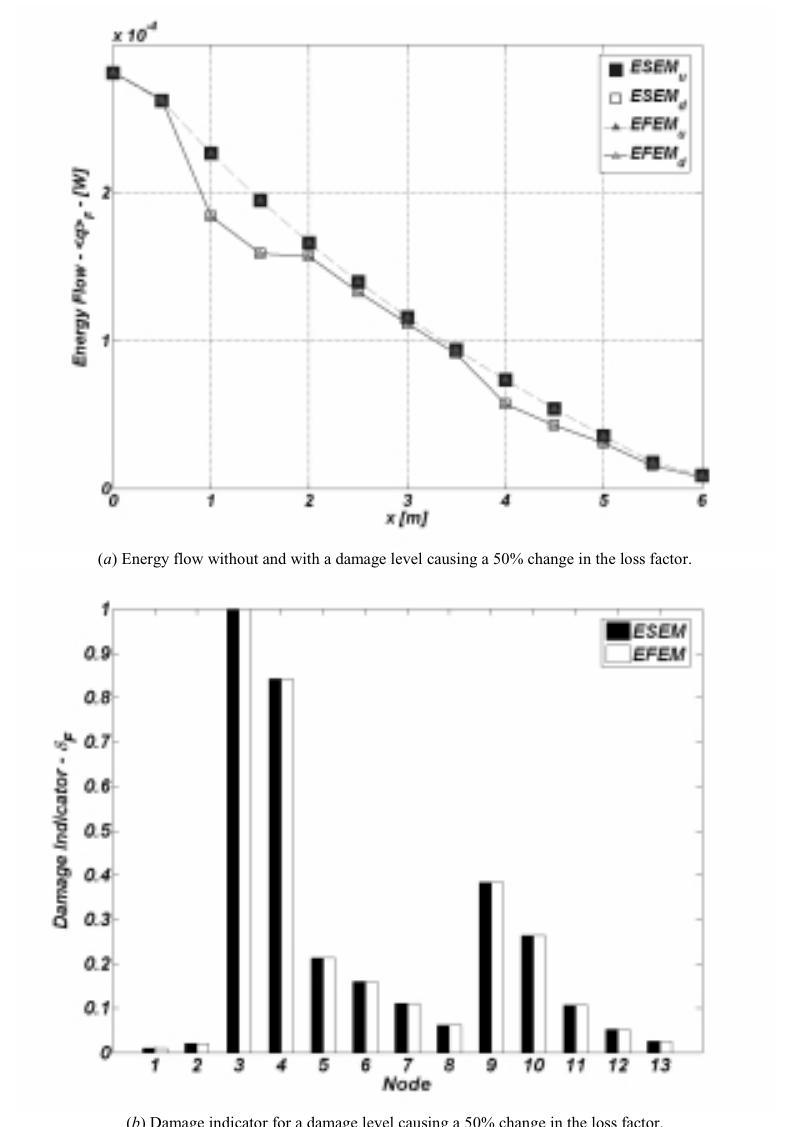
Fig. 6. Flexural energy flow and damage indicator by ESEM and